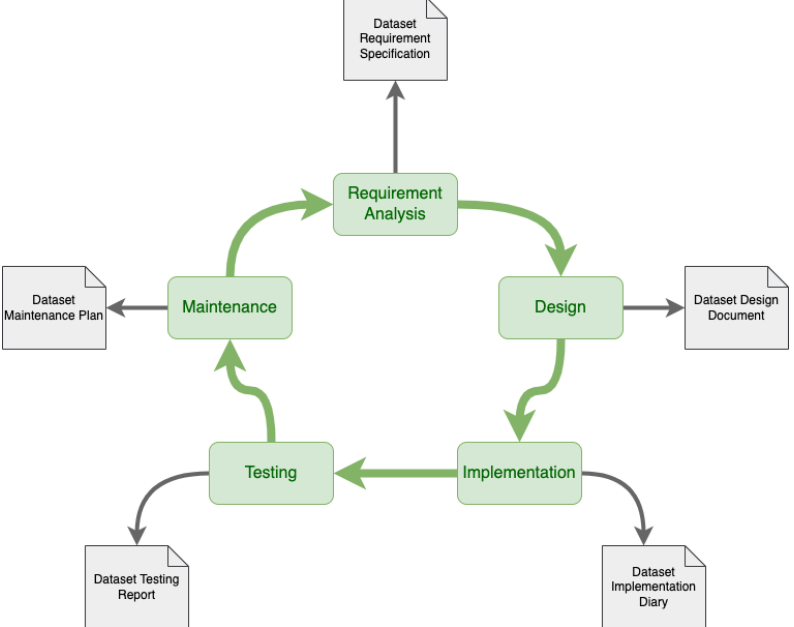
Figure 14. A lifecycle model for the production and release of open datasets, adapted from Hutchin- son et al.